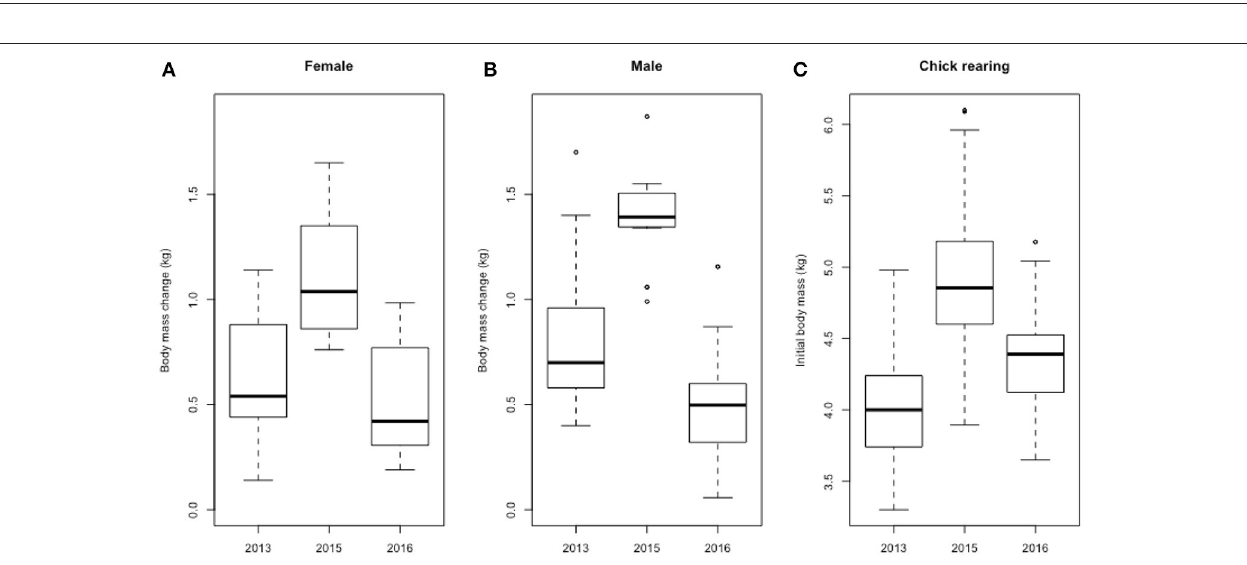
FIGURE 4 | Body mass changes (kg) over the first incubating foraging trips of females (A) and males (B) , and initial body mass of chick-rearing Adélie penguins (C) , over the 3 years considered in this analysis (2013, 2015, and 2016 stands for 2013–14, 2015–16 and 2016–17,